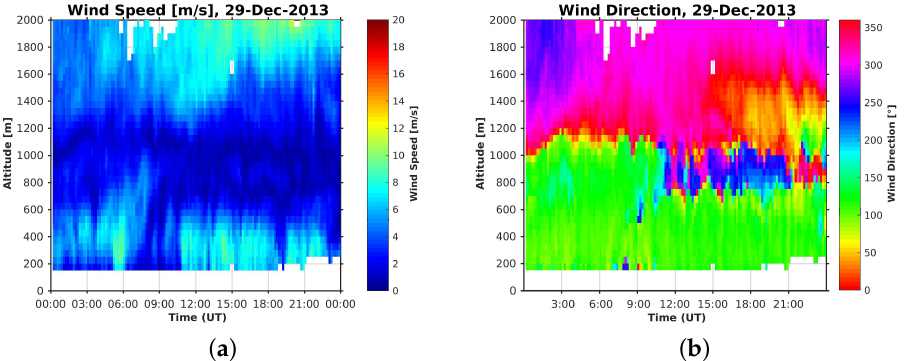
Figure 9. Example for different rotations to connect a constant surface wind with the synoptic flow. ( a ) Wind speed of 29 December 2013. ( b ) Wind direction of 29 December